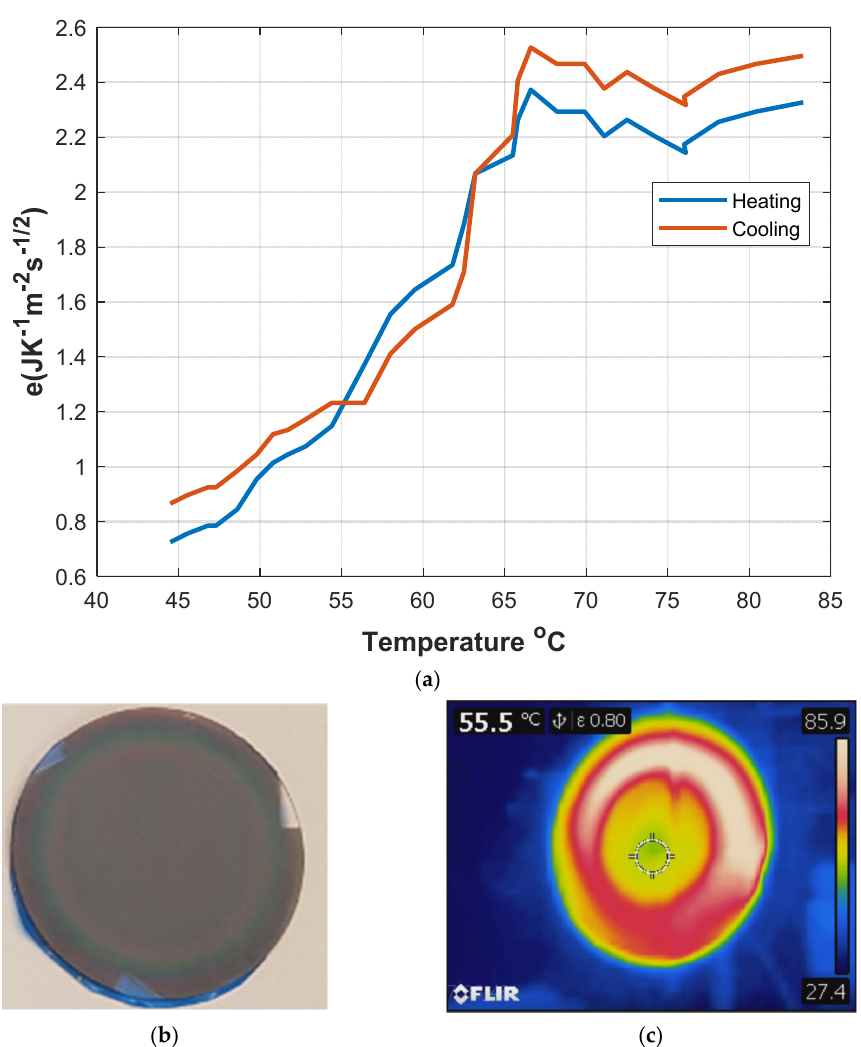
Figure 4. ( a ) Estimated thermal effusivity of the wafer containing a 2-inch circular VO 2 thin layer with 400 nm thickness on 275 µm sapphire substrate. ( b ) VO 2 sample. ( c ) The thermal infrared image is taken from the FLIR camera of the VO 2 sample.